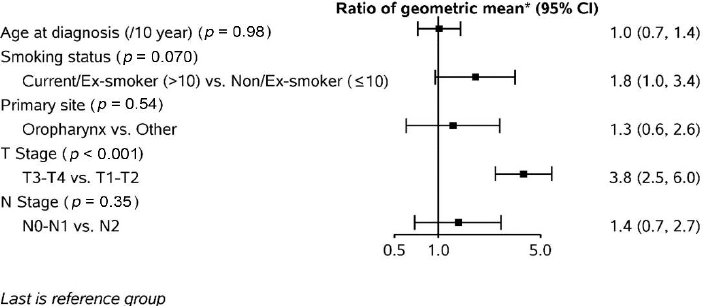
Figure 2. Factors associated with primary tumour volume reduction from pre-treatment to post- treatment. * Ratio of the geometric mean was calculated by log-linear regression models. The GTV reduction was log-transformed in a linear regression model. 3.3. Nodal Gross Tumour Volume (GTV) Changes Thirty-one (76%) patients had a total of 46 nodes evaluable. The median total nodal volume was 12.4cc (range: 8 – 21cc). Figure 1 depicts the mean change in nodal volume over time. The change over time was significant ( p < 0.0001) but when normalized to the pre-treatment volume, only the weekly changes from week 2 onwards are statistically significant (week 2 p = 0.002; week 3 to post-treatment p < 0.0001). The average nodal volume reduction per week was 1.7cc. No clinical features were found to correlate with nodal volume reduction. 3.4. Apparent Diffusion Coefficient (ADC) Changes Figure 3 shows the trajectory of the absolute ADC measurements and ADC values normalized to pre-treatment values for primary tumour sites. Although there was an overall trend of increasing absolute ADC values over time, when normalized to pre- treatment values, we observed a steep increase in ADC values from pre-treatment to week 2, minimal change between weeks 2 and 5, and then a steep increase in ADC values from week 5 to post-treatment. Although there is an overall rise in ADC values across all